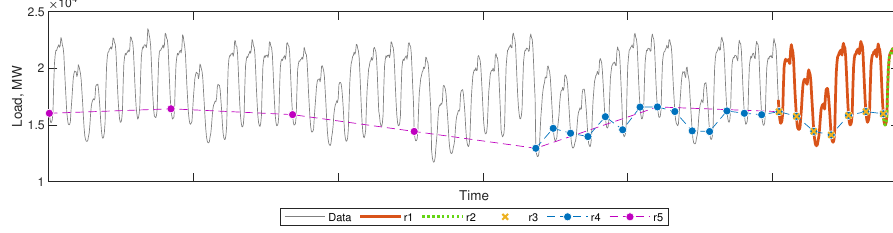
Figure 1. Load time series points used for input patterns construction.